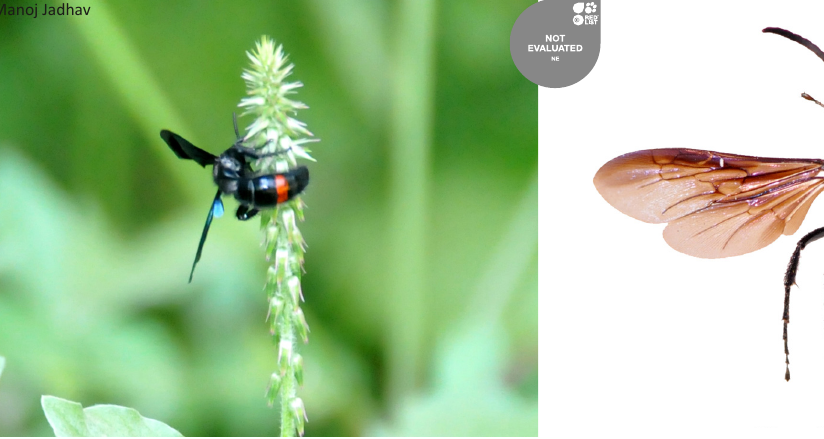
Image 2. S. ( Discolia ) fasciatopunctata dunensis : A male mounted on